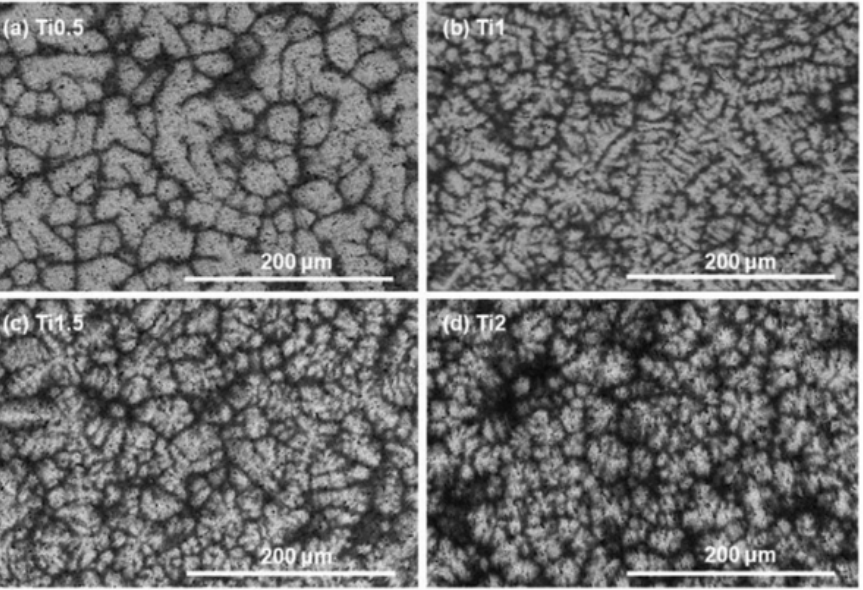
Figure 4. SEM images of alloys ( a ) Ti 0.5 ZrNbTaMo, ( b ) TiZrNbTaMo, ( c ) Ti 1.5 ZrNbTaMo and ( d ) Ti 2 ZrNbTaMo (from [20]). Reprinted with permission from Elsevier: J. Alloys Compd. Copyright 2022, License: